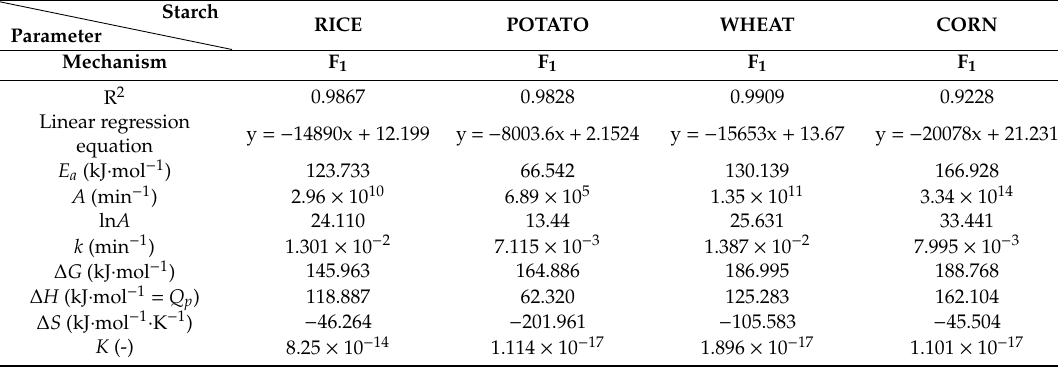
Table 3. Estimation of the kinetic and thermodynamic parameters of starch